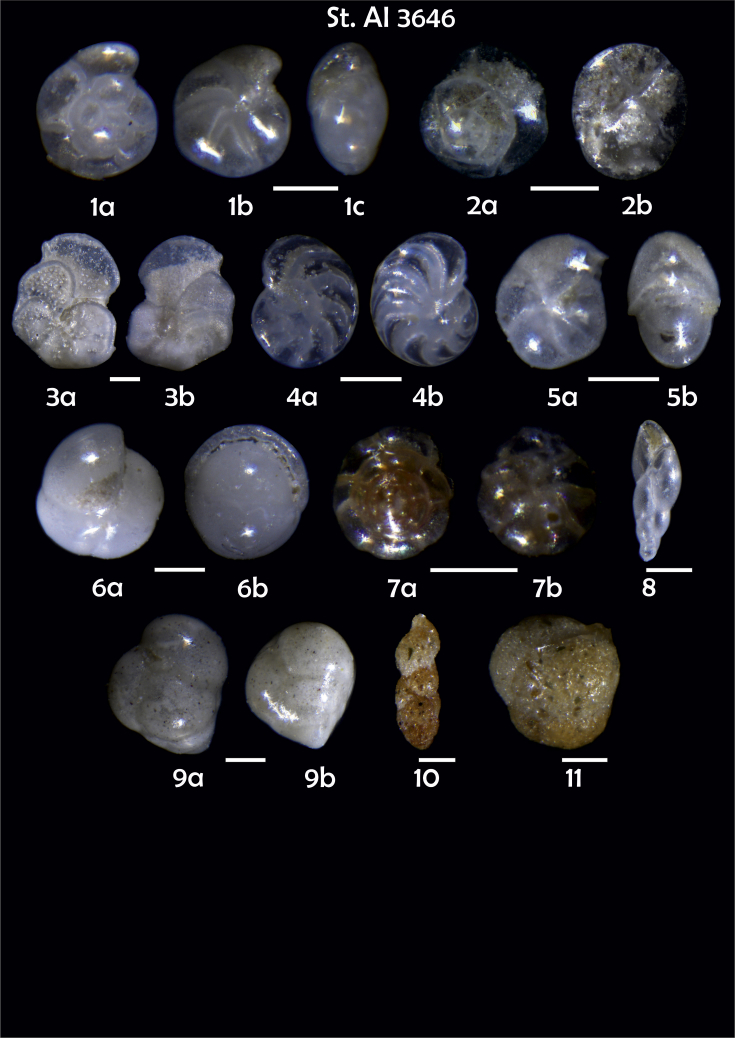
Station 36461Oridorsalis umbonatus, a spiral view, b umbilical view, c apertural view. 2Epistominella exigua, a spiral view, b umbilical view. 3Cibicidoides sp., a umbilical view, b spiral view. 4C. wuellerstorfi, a umbilical view, b spiral view. 5Pullenia quinqueloba, a side view, b apertural view. 6P. bulloides, a side view, b apertural view. 7Ionella tumidula, a spiral view, b umbilical view. 8Fursenkoina complanata. 9Eggerella bradyi, a apertural view, b lateral view. 10Karrerulina conversa. 11Cribrostomoides subglobosus. Scale 100 μm.